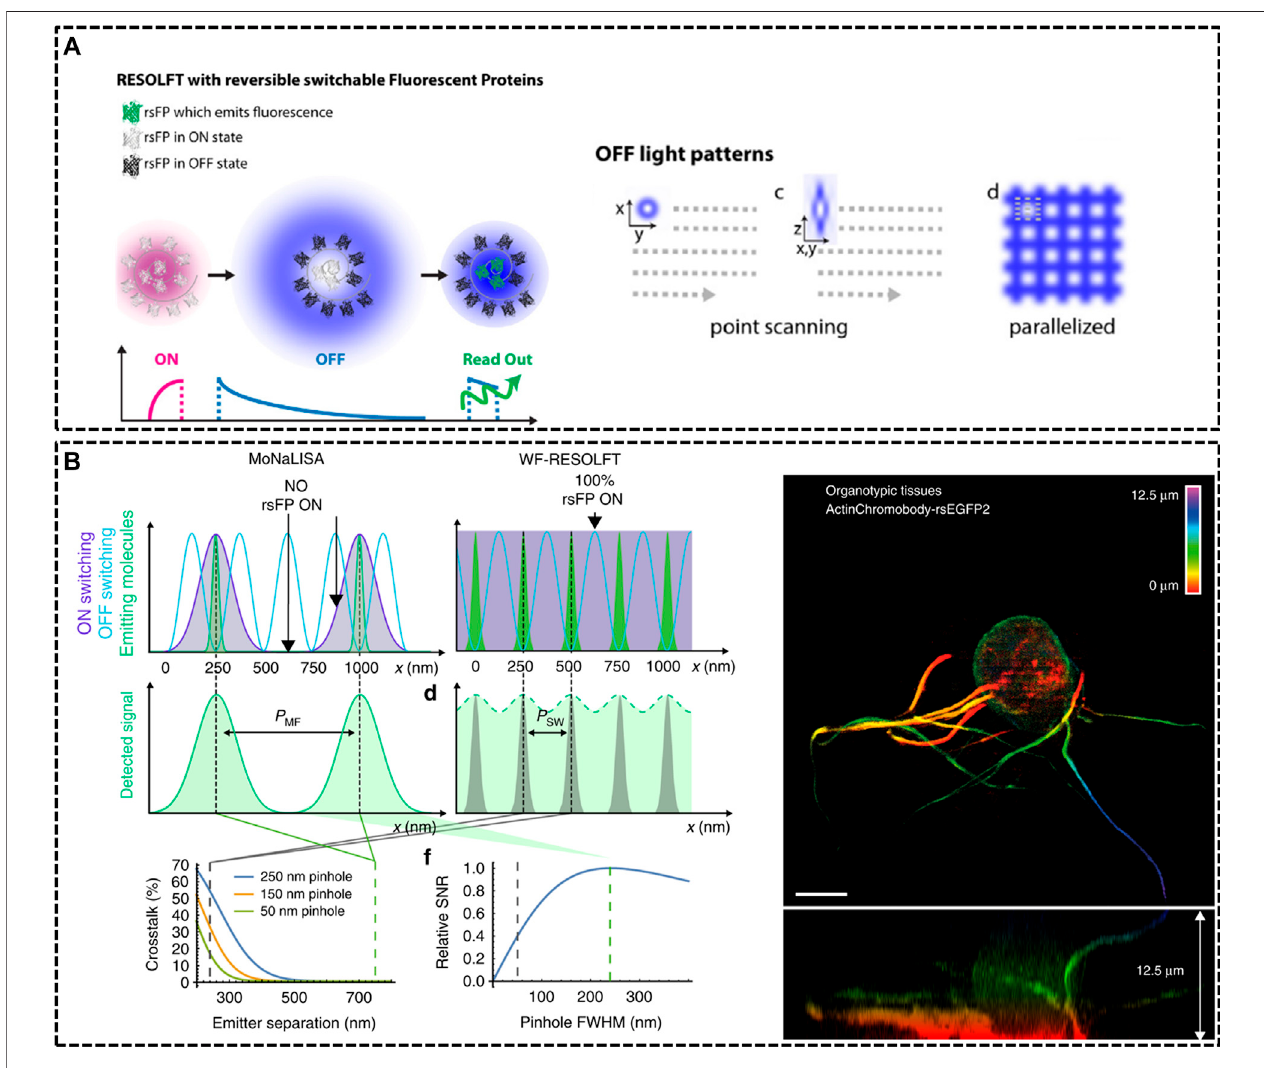
FIGURE2| Modi fi edRESOLFTtechniqueswithreversiblephotoswitchable fl uorescentproteinsfor invivo imaging. (A) Left:illustrationofthetypicalpulsemodefor RESOLFT. Right: Off light pattern implemented in point scanning and parallelized RESOLFT microscopy (Hell et al., 2015). Reprinted from Hell et al. (2015) with permission from IOP Publishing. (B) Schematic representation of Molecular Nanoscale Live Imaging with Sectioning Ability (MoNaLISA) and the actin recorded in a 12.5 μ m organotypic hippocampal rodent brain tissue (Masullo et al., 2018). Scale bar, 5 μ m. Reprinted from Masullo et al. (2018) with permission from Springer